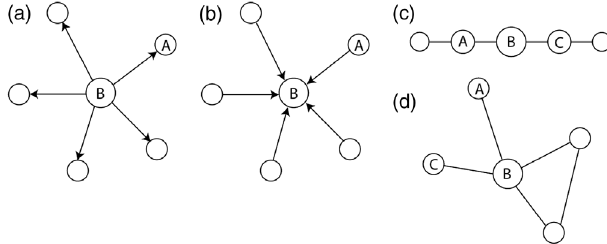
FIG. 3. Visualization of the four centralities used in this work. In each case, B has higher centrality than A according to (a) outdegree (a measure of engagement), (b) indegree (a measure popularity or sociability), (c) betweenness (a measure of control over the flow of information through the network), and (d) close- ness (a measure of overall connectivity or embeddedness within the entire network). Adapted from Ref.